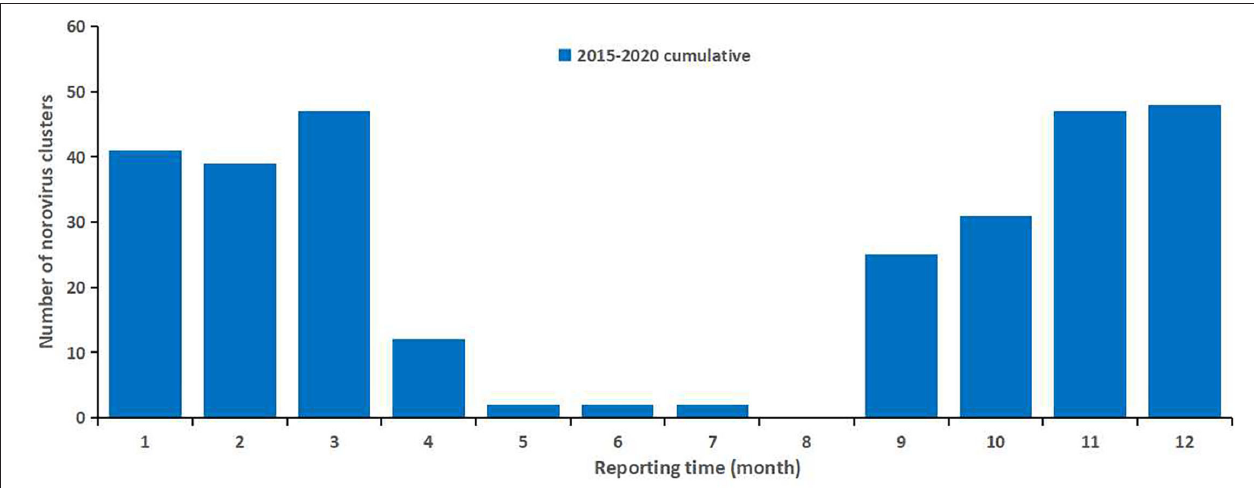
FIGURE 2 | The monthly number of norovirus clusters reported in Guangzhou, 2015–2020. The height of the blue column represents the number of clusters. The peak occurred from November to March of the subsequent year.